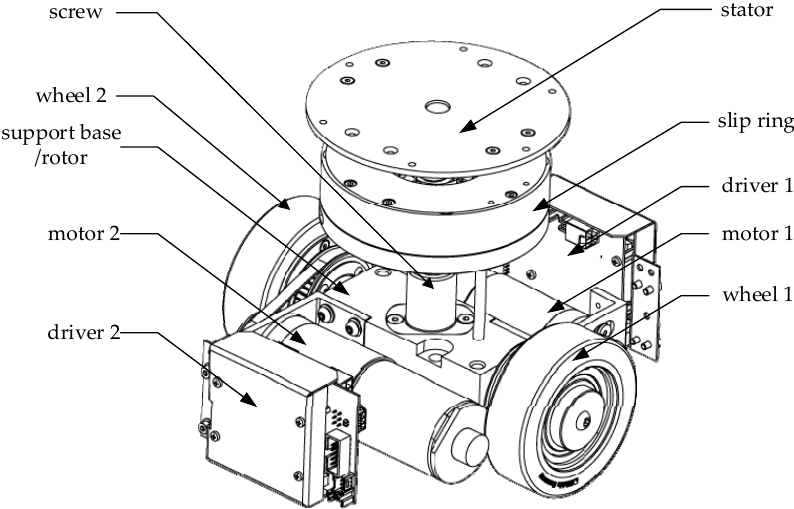
Figure 1. Three dimensional sketches of the compact driving unit.